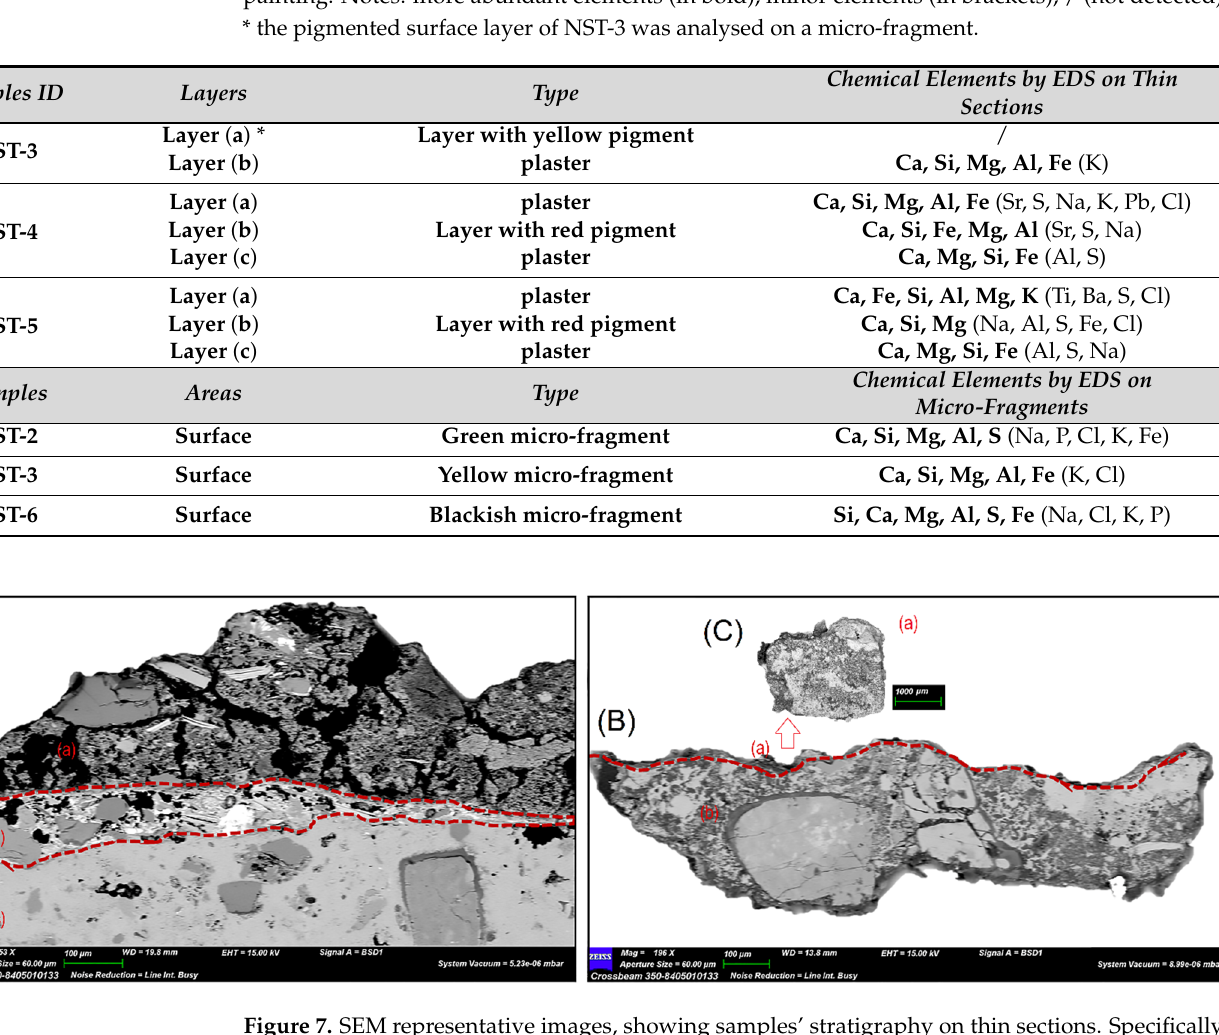
Figure 7. SEM representative images, showing samples’ stratigraphy on thin sections. Specifically: ( A ) sample NST-5 with evidence of 3 layers named as ( a – c ); ( B ) sample NST-3 with evidence of 2 layers named as ( a , b ). All layers were analysed by EDS (Table 3); for NST-3 analysis was also performed on a residual of micro-fragment ( C ) related to layer ( a ) of the same samples because the pigmented layer had clearly detached from the stone support during section preparation. Table 3. EDS chemical data detected for both thin sections and micro-fragments of “Virgin” mural painting. Notes: more abundant elements (in bold); minor elements (in brackets); / (not detected); * the pigmented surface layer of NST-3 was analysed on a micro-fragment.